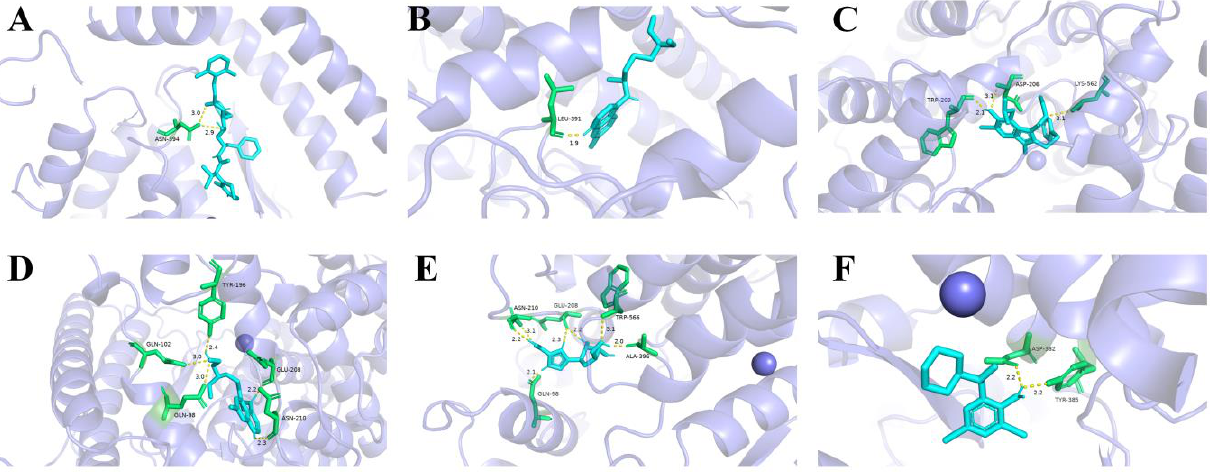
Figure 8. 3D schematic diagram of the molecular docking simulation of the spike protein with ( A ) lopinavir, ( B ) chloroquine diphosphate, ( C ) abridol, ( D ) hydroxychloroquine, ( E ) ribavirin, and ( F ) bromhexine.